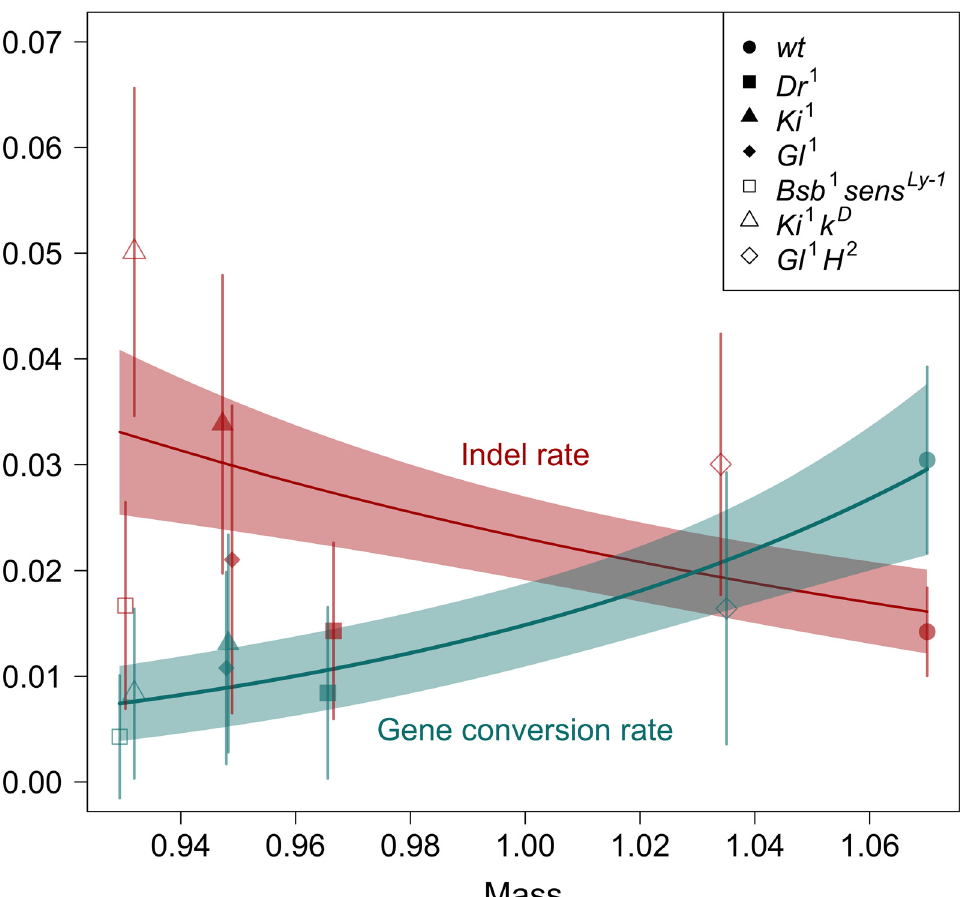
Fig 3. Indel and gene conversion rates are related to body mass. Rates per haploid 2nd chromosome per generation versus dry mass of males relative to a standard genotype reared in the same vial [6]. Indel rate declined significantly with body mass (GLM: Z = − 2.12, p = 0.034) and gene conversion rate increased significantly with body mass (quasi-Poisson GLM: t = 2.42, p = 0.021; GLMM: χ 2 = 4.80, p = 0.029). Lines and shaded regions are predicted values and standard errors from (quasi) Poisson GLMs on 38 samples. Points are predicted values for each of the seven genetic backgrounds, with horizontal jitter added for clarity. Legend indicates the treatment alleles on each genetic background ( wt = wild-type, i.e., the unloaded treatment). See S1 Data for plot data.